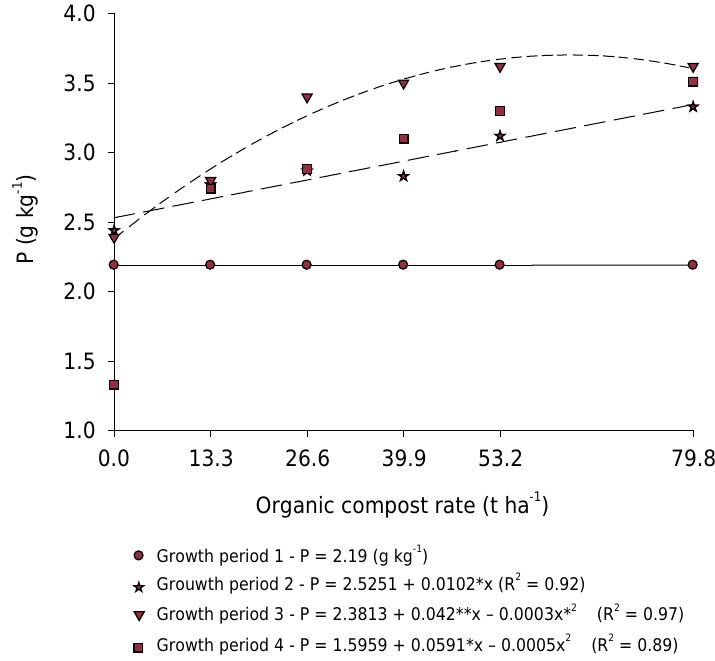
Figure 3. Phosphorus content in the elephant grass sample leaf in response to organic compost rates, in different growth periods. * and **: significant at 5 and 1 % probability, respectively.